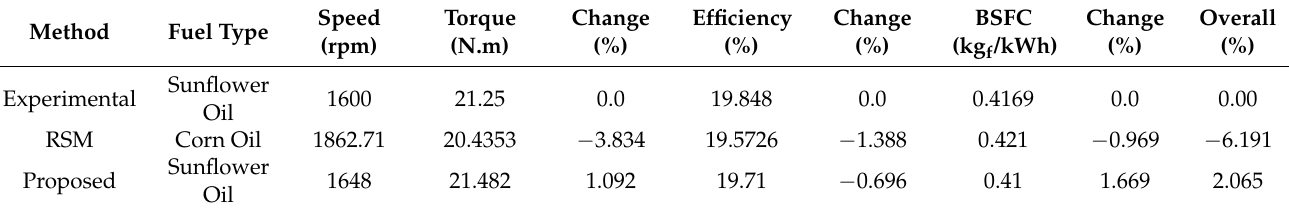
Table 13. Performance comparison of experimental, RSM and proposed